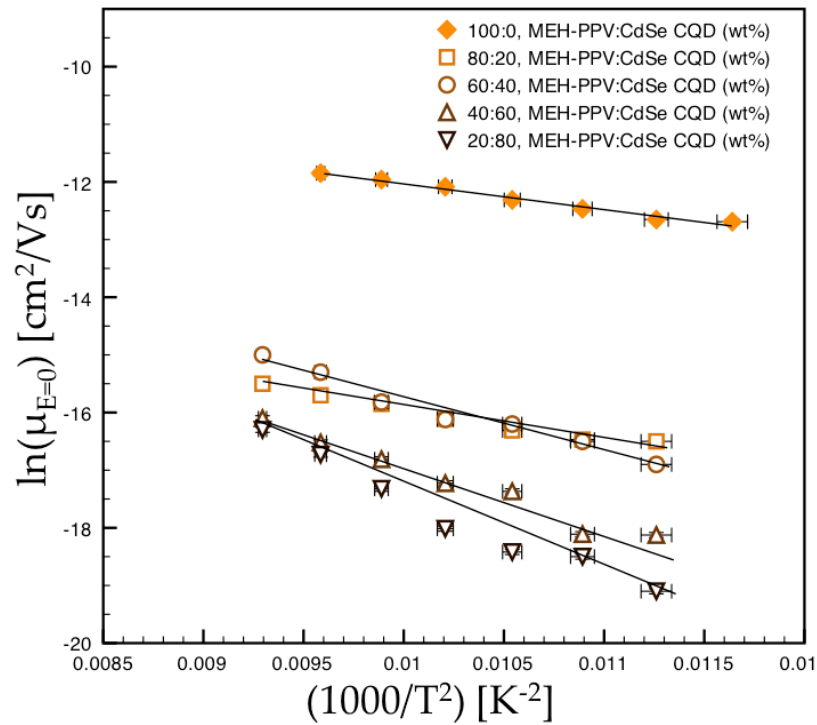
Figure 4. Non-Arrhenius plot of the hole drift mobility at zero-field [ μ (E = 0)] as a function of inverse